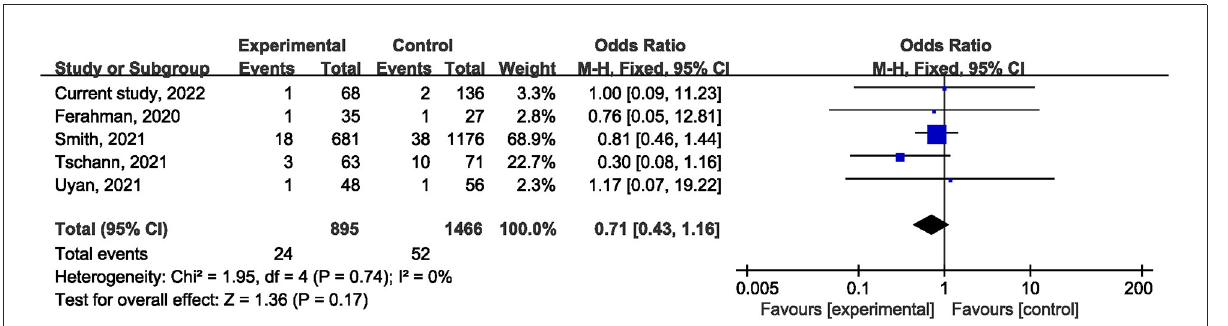
FIGURE3 The impact of the COVID-19 pandemic on the incidence of anastomotic leakage.